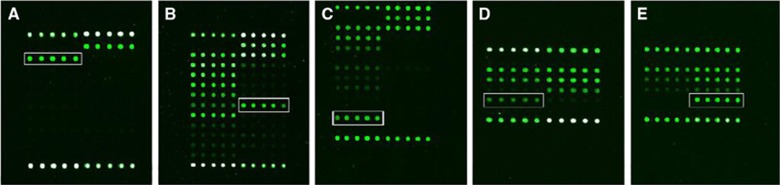
Hybridization pattern of spinal tuberculosis specimens obtained with the DNA probe. (A) Hybridization patterns on the gene chip used to identify M. tuberculosis strains (white frame). (B) RMP resistance detected by the presence of the rpoB 531 (TCG->TTG) mutation; the hybridization signal generated by probe TCG531TTG (solid rectangle) is more intense than that generated by the corresponding wild-type probe (dashed rectangle). (C) RMP resistance detected by the presence of the rpoB 516 (GAC->GTC) mutation; the hybridization signal generated by probe GAC516GTC (solid rectangle) is more intense than that generated by the corresponding wild-type probe (dashed rectangle). (D and E) INH resistance tested by the presence of the katG 315 (AGC->ACC) mutation; the hybridization signals generated by the katG probe AGC315ACC (solid rectangles) are more intense than those generated by the corresponding wild-type probe (dashed rectangles). (E) INH resistance detected by the presence of the inhA-15 C-T mutation; the hybridization signal generated by the inhA 15C→T probe (solid rectangle is higher than that generated by the corresponding wild-type probe (dashed rectangle). (Figures 1, 2, 3 were from a previous publication by our team that appeared in BMC Infectious Diseases 2012).